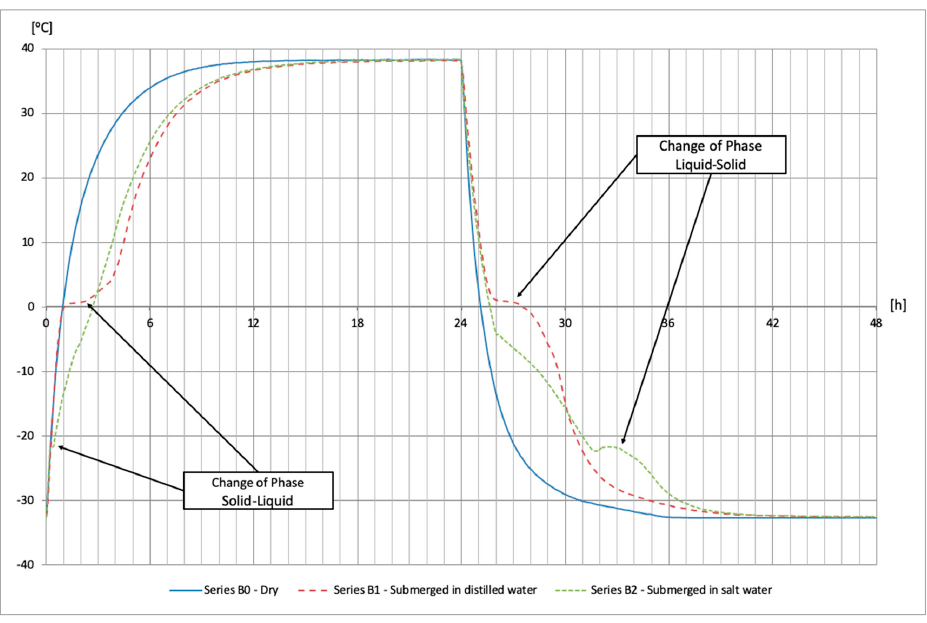
Figure 2. Freeze–thaw cycle.